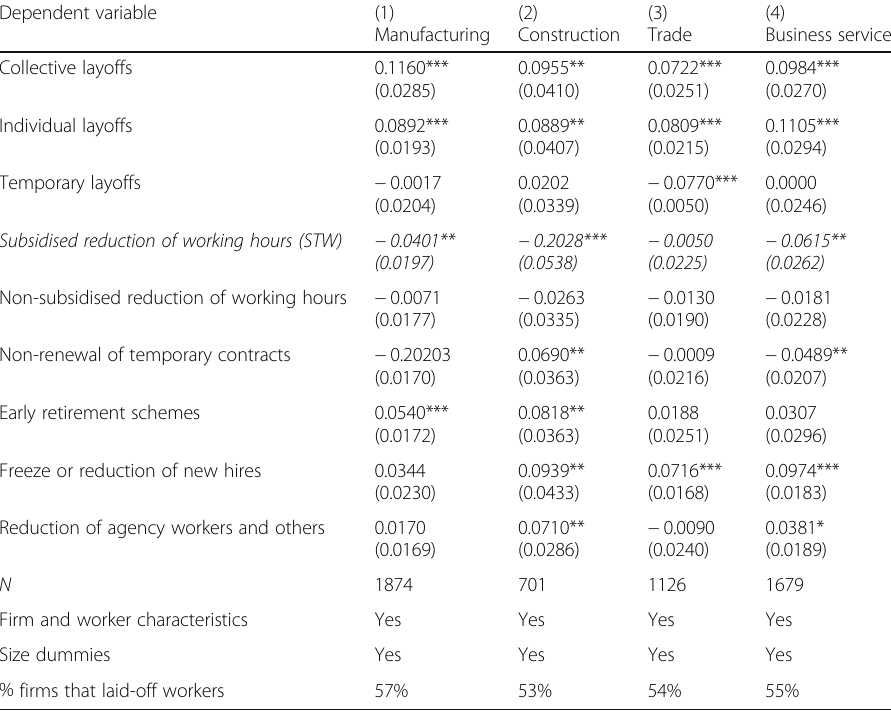
Table 8 The effect of STW usage on the propensity to lay off permanent workers Dependent